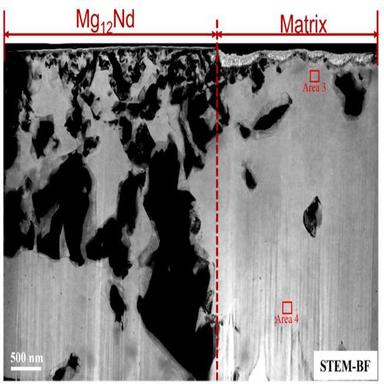
STEM-BF image showing the cross-sectional morphology of α-Mg matrix and Mg12Nd precipitate of ZM6 alloy after oxidation for 100 h.